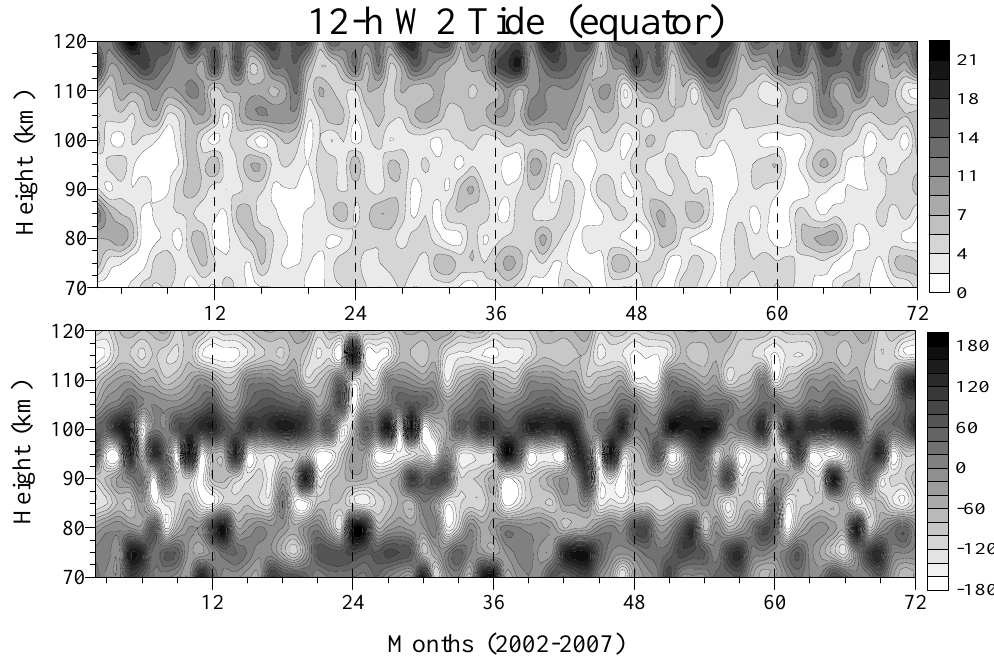
Figure 8 Fig. 8. Altitude-time cross sections of the tidal amplitude (upper plot) and phase (bottom plot) of the semidiurnal tide over the equator.